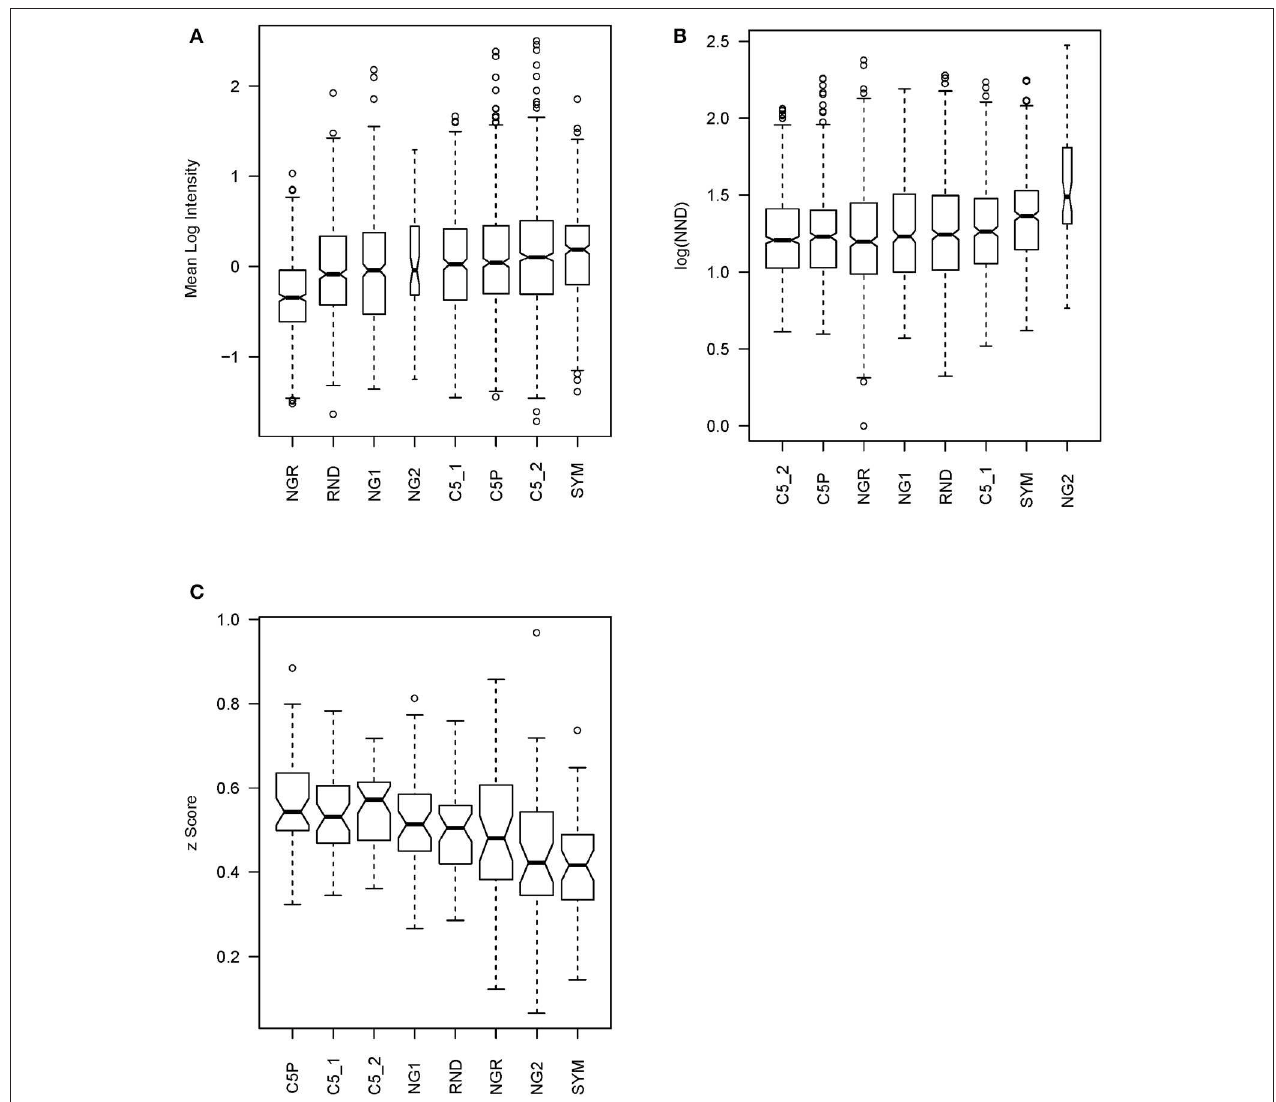
FIGURE 4 | Statistics testing the libraries’ capacity to probe the mimotope reactivity space. (A) Mean reactivity of each peptide across patients grouped by library. The optimized library SYM has the highest reactivity. For library content, see Table 1 . (B) Mean nearest neighbor distance of the peptide profiles across 10 patients in each library. (C) Mean correlation of patient profiles across the peptides in each library compared after z transformation. This test has a similar meaning as the previous but is performed on the transposed matrix. The optimized library SYM provides the least correlated patient reactivity profiles, which indicates a high potential to reflect the natural diversity of the human population but increases the requirements for the size of the teaching sets to extract models of good generalization. The optimized library SYM appears to sample the mimotope reactivity space evenly. The width of the bars is proportional to the size of the